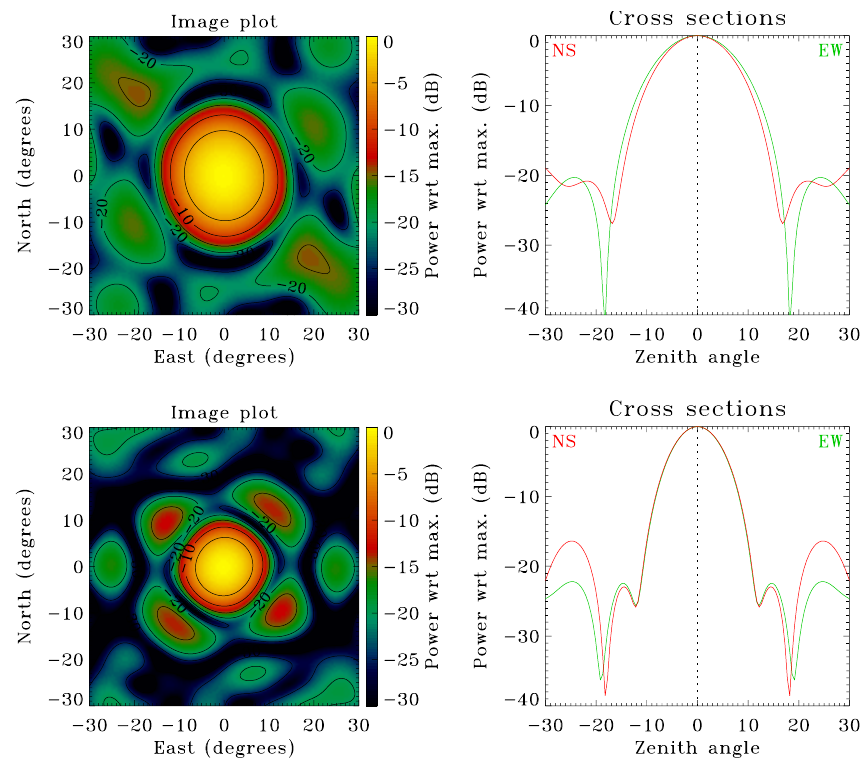
Fig. 4. Polar diagrams employed for routine observations using the Buckland Park MF radar. The top plots show image (left) and cross- sections (right) plots obtained using channels 1 to 10. The bottom plots show the corresponding plots using channels 1 to